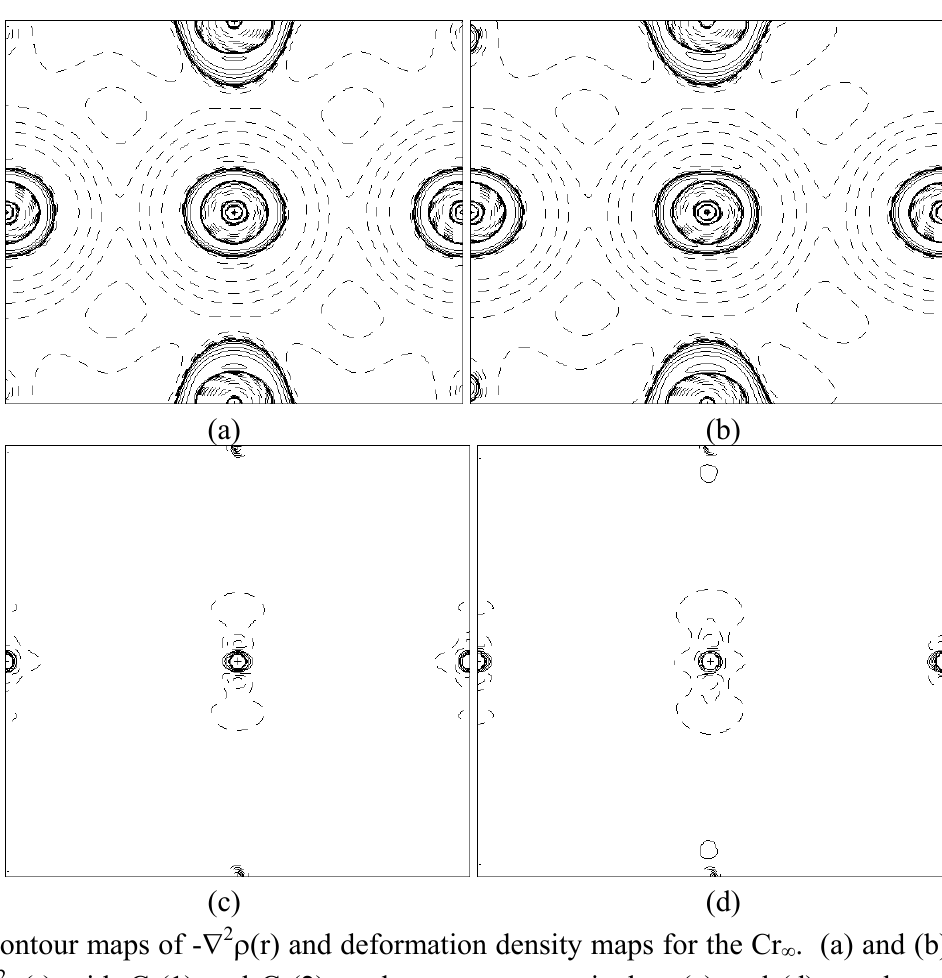
Figure 7 Contour maps of - ∇ 2 ρ (r) and deformation density maps for the Cr maps of - ∇ 2 ρ (r) with Cr(1) and Cr(2) as the center respectively. (c) and (d) are the corresponding deformation density maps. The rest are the same as those found in Figure